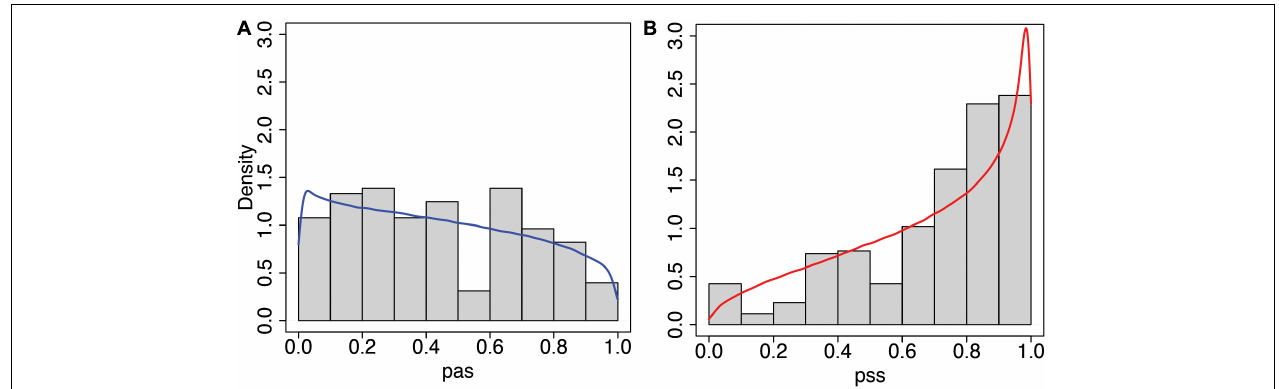
FIGURE 6 | Histograms and predicted posterior distributions of the questionnaire scores from the statistical model (Eqs 2, 3). (A) Asynchronous ( pas ) and (B) Synchronous ( pss ). In each case, the predicted posterior distributions are the curves shown over the histograms of observed data. The model fits the data well, including the characteristic shift towards higher scores in the synchronous condition. This can be compared with the model that uses a normal distribution shown in Supplementary Figure 1 .